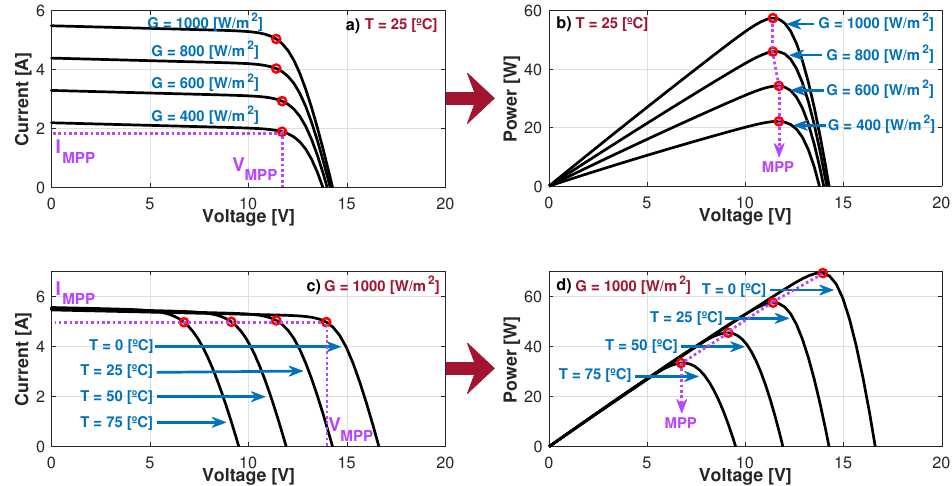
Figure 4. Graphical exemplification of the maximum power point for different irradiation ( a , b ) and temperature ( c , d )